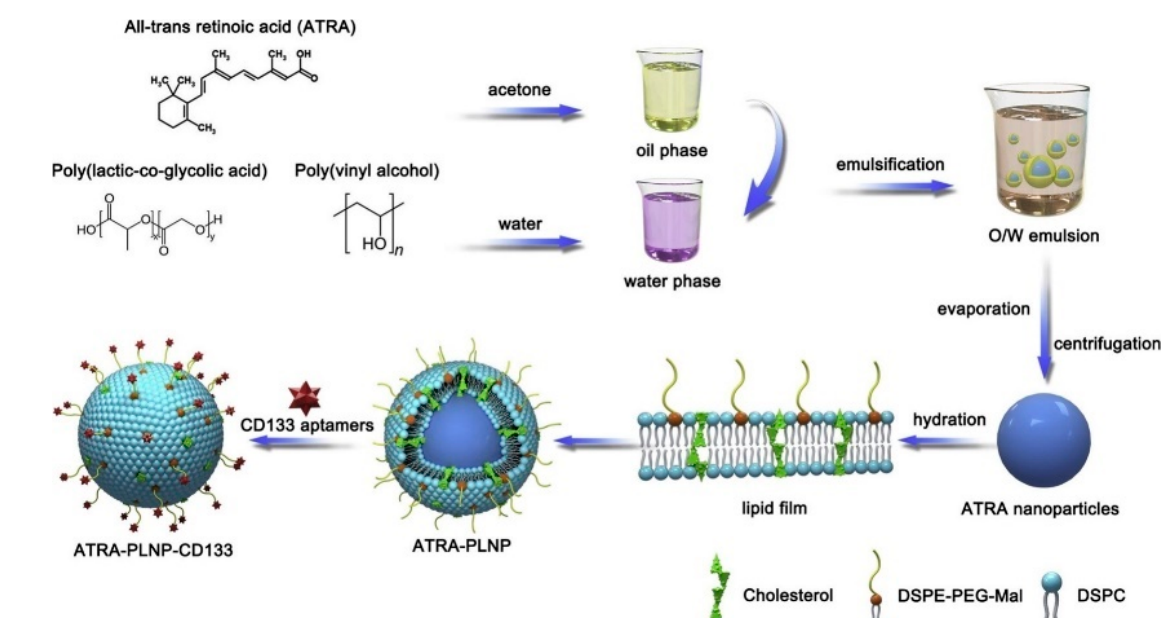
Figure 13. The scheme of preparation of ATRA-loaded lipid-polymer nanoparticles. The oil phase was formed by dissolving ATRA and PLGA in acetone. Then, the oil phase was slowly injected into poly(vinyl alcohol) (PVA) solution by homogenization. After the recovery by evaporation and centrifugation, the PNPs were hydrated with the lipid film. The CD133 aptamers were conjugated to the nanoparticles by the interaction of the maleimide on nanoparticles and the sulfhydryl groups of CD133 aptamers. Adopted from Gui et al. [220].